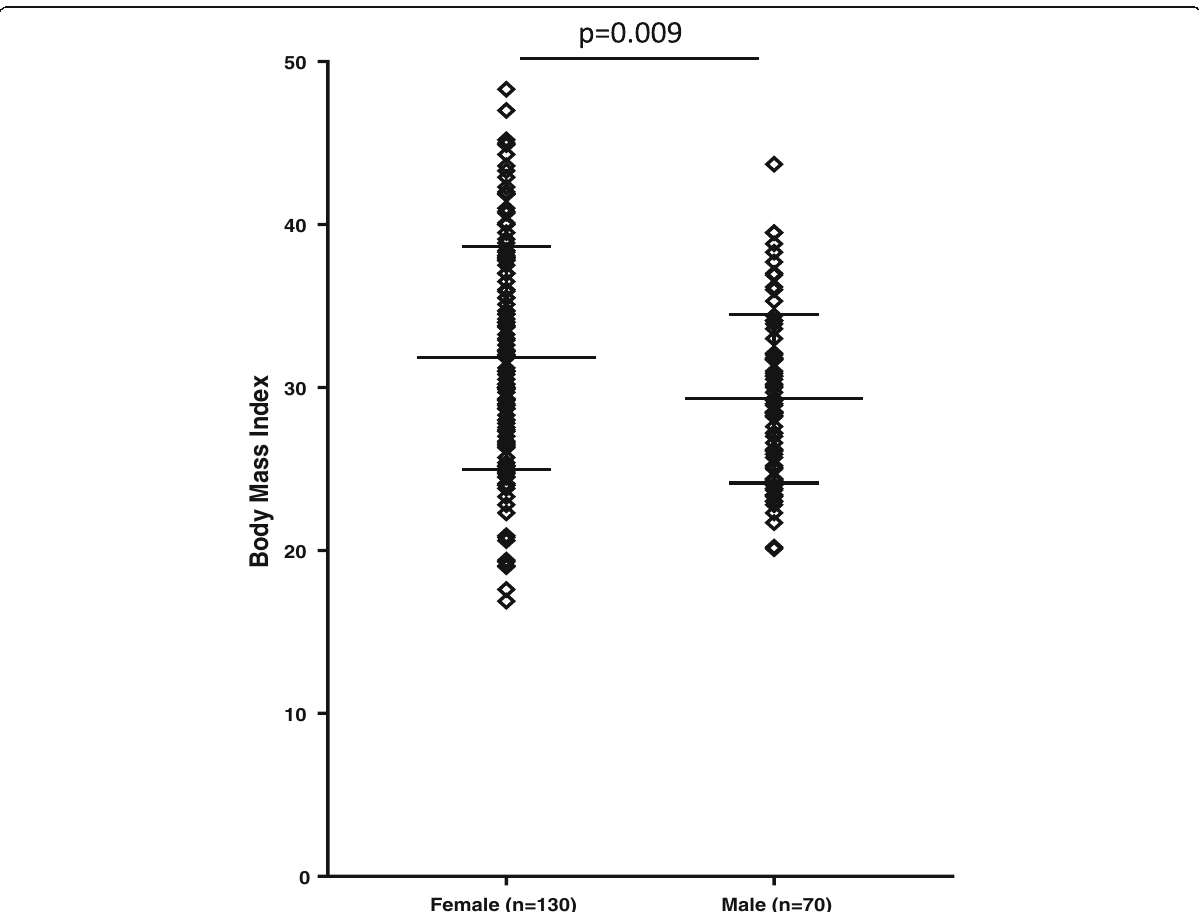
Fig. 1 Body mass index distribution by gender. Distribution of body mass index is shown for 130 females versus 70 males. Horizontal bars mark means and standard deviations for each